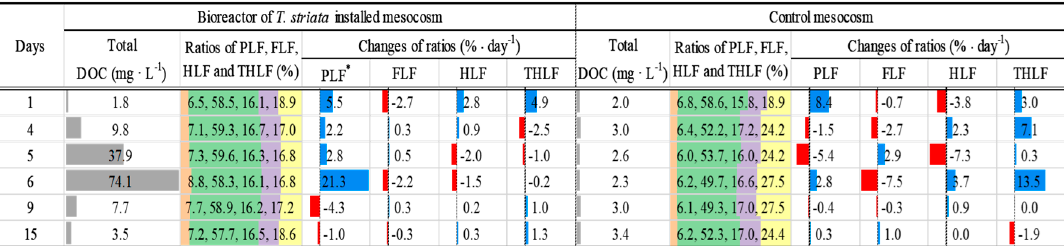
Figure 6. Dynamics of abundance of Tetraselmis striata cells cultured in bioreactors, and concentrations of dissolved organic carbon in bioreactor installed mesocosms and control mesocosms during mesocosm experiment period (15 days).